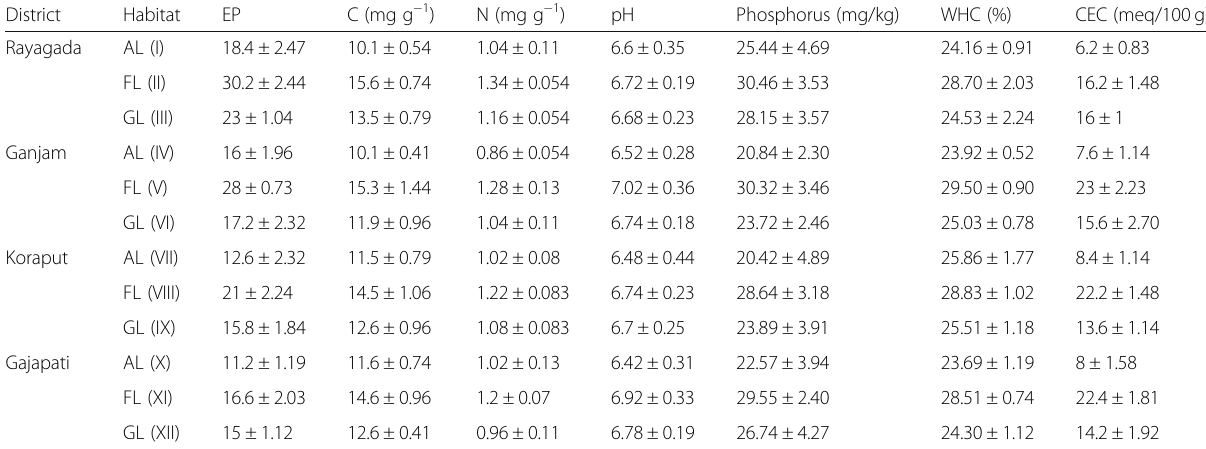
Table 3 Physico-chemical parameters of soil habitats of southern parts of India